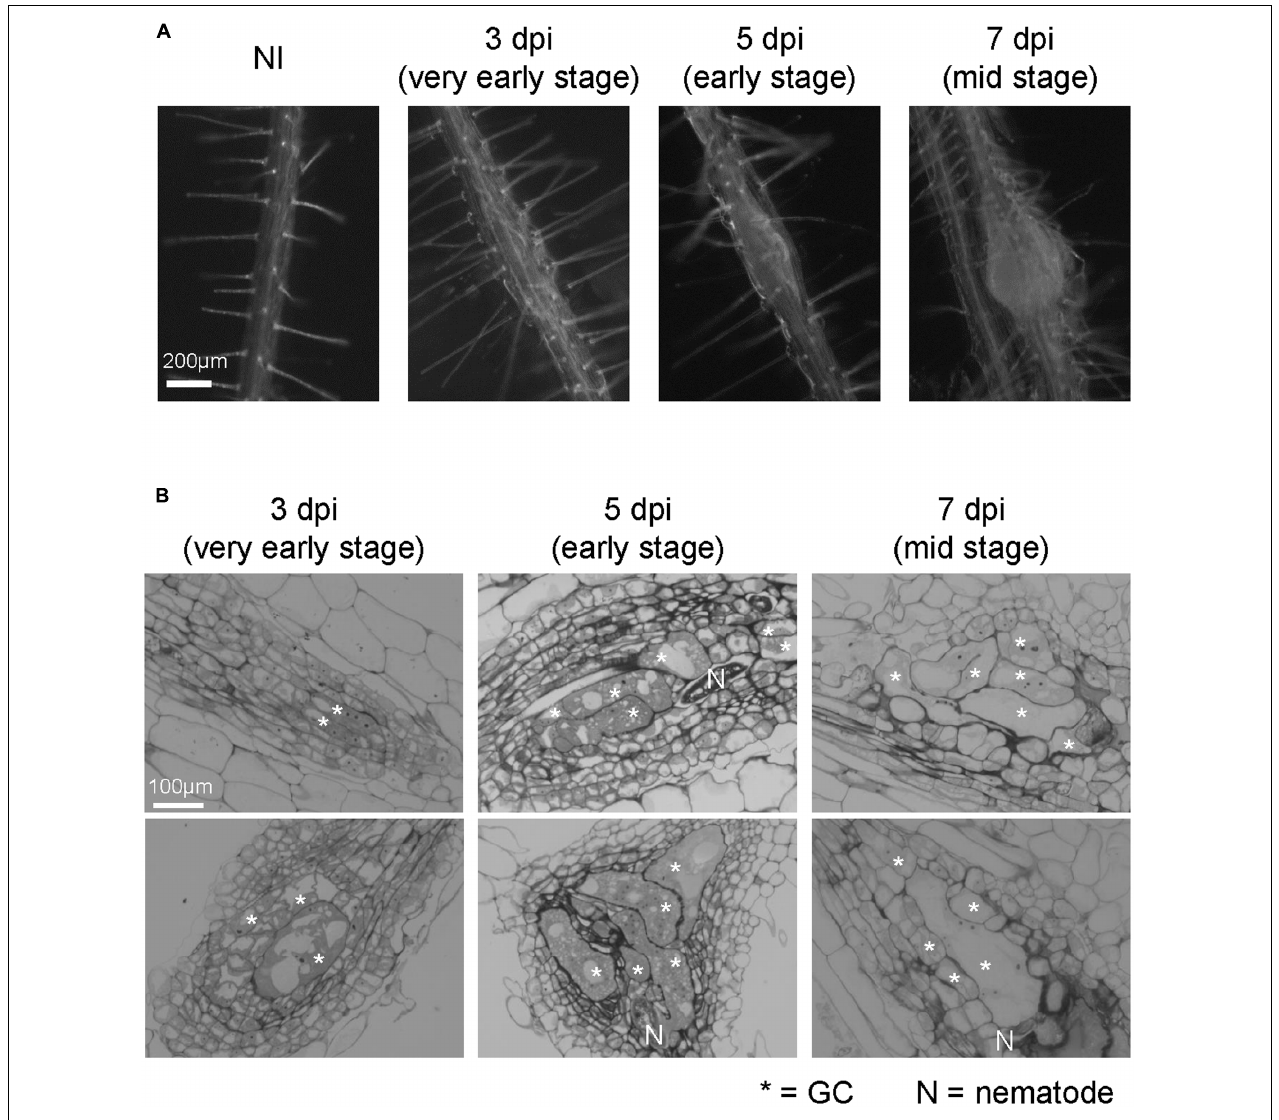
FIGURE 1 | Growth dynamics of M. incognita -induced galls in the in vitro assay system. (A) Representative images of non-infected roots (NI) and galls at 3, 5, and 7 dpi. Roots were grown on an agar medium and then inoculated with surface-sterilized RKNs 5 days after germination. Scale bar = 200 µ m. (B) Histological characterization of 3, 5, and 7 dpi galls. Upper panels show sections obtained from smaller galls, lower panels show sections obtained from larger galls. Scale bar = 100 µ m. Asterisks indicates GCs, N indicates